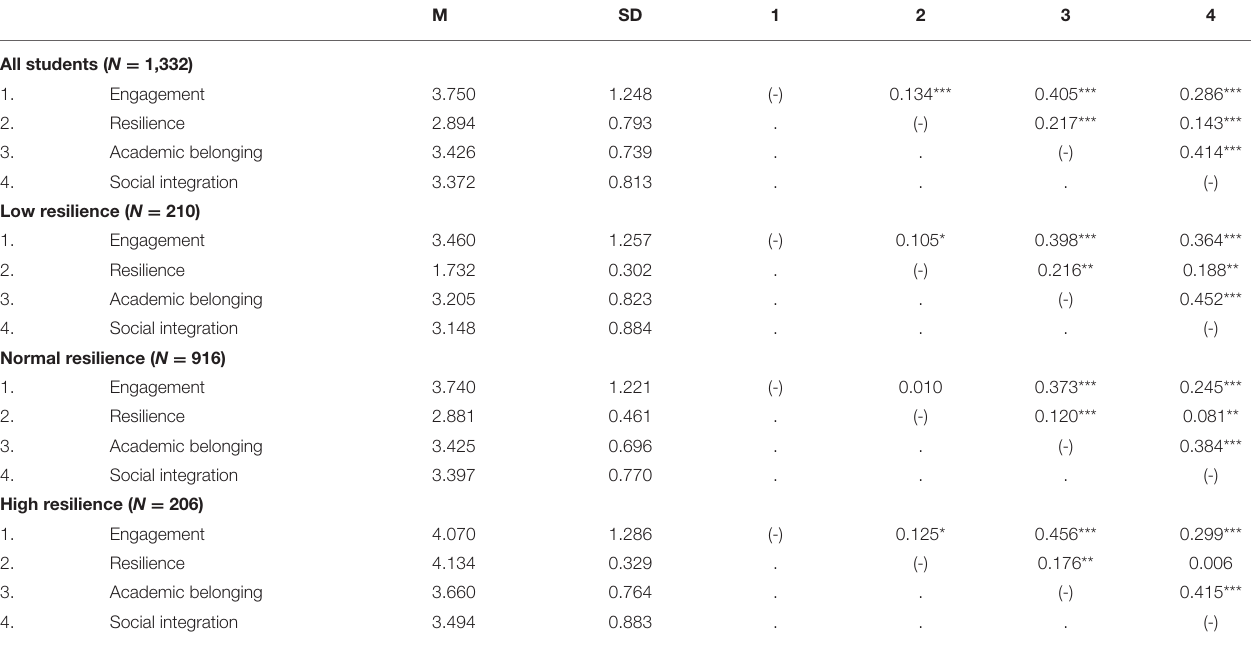
TABLE 3 | Descriptive statistics and Pearson’s correlations of engagement, resilience, academic belonging, and social integration measures for all HE students and resilience groups. M